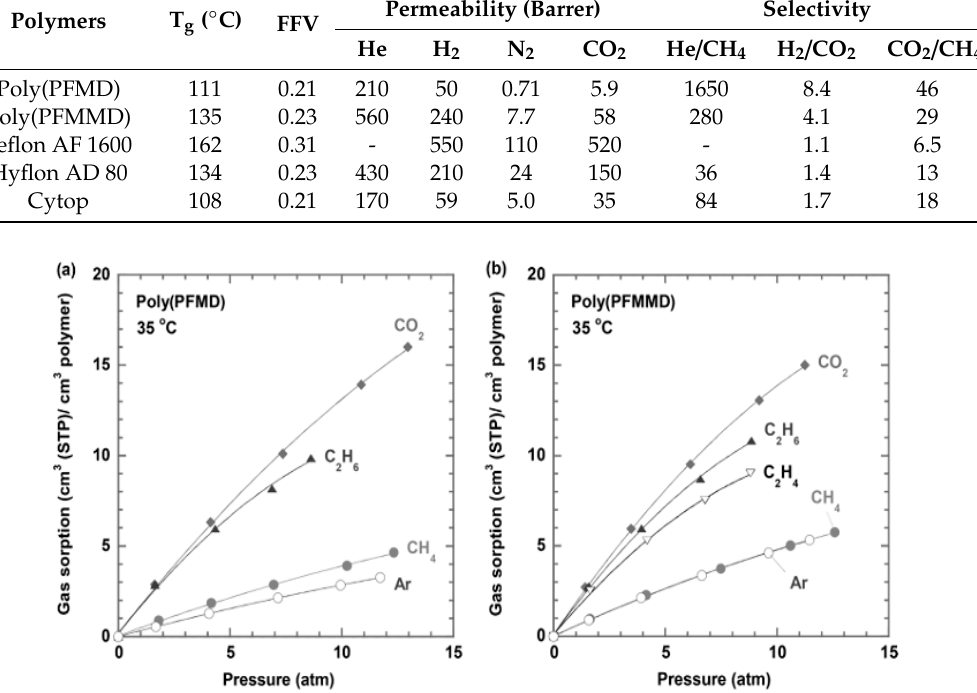
Figure 9. Pure-gas sorption isotherms for various gases in ( a ) poly(PFMD) and ( b ) poly(PFMMD) films at 35 °C [28].